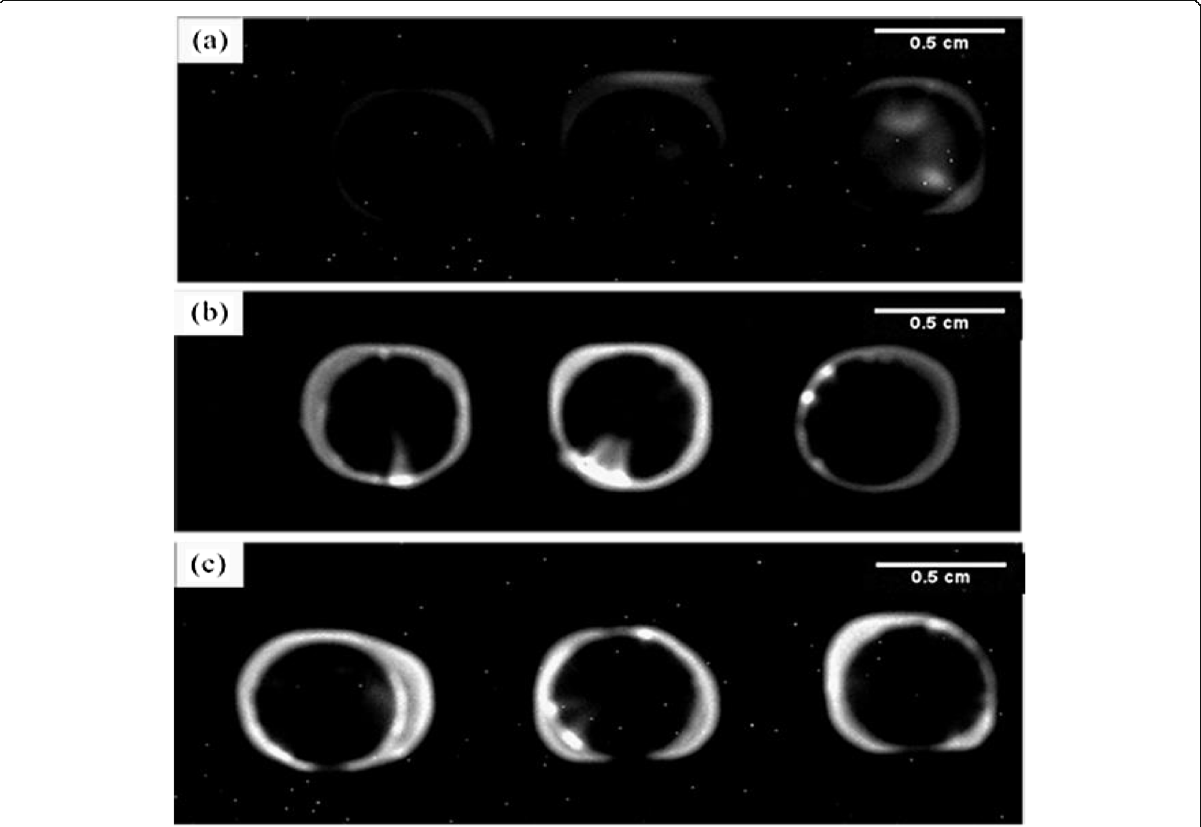
Fig. 10 CL image of Zebrafish whole-body sample spiked standard cortisol solution (50 ng ml − 1 ) added to ferrocene anti-cortisol antibody immobilized onto modified ITO electrode a without extraction, b with extraction and c fish sample without the addition of standard and without extraction. Scale bar is 0.5 cm